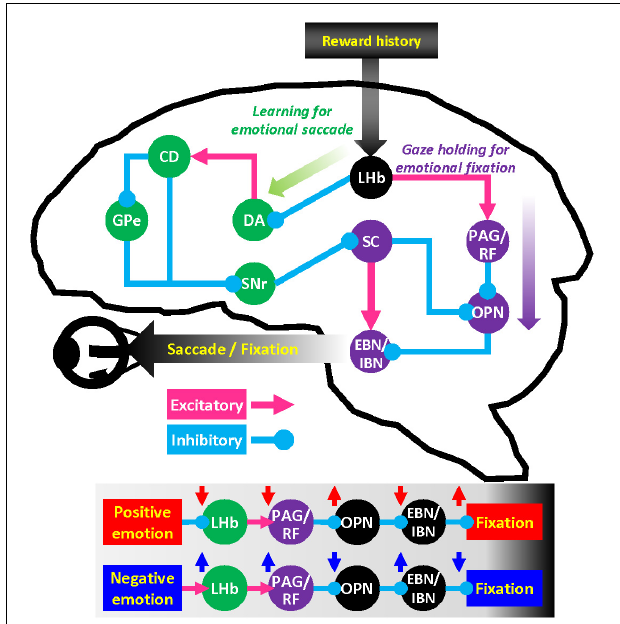
FIGURE 4 | Hypothetical network for the influence of emotion on gaze. LHb neurons regulate dopamine (DA) neurons in substantia nigra pars compacta and ventral tegmental area through rostromedial tegmental nucleus. Dopamine neurons in turn send signals to caudate head (CD) nucleus that projects to superior colliculus (SC) via the external segment of the globus pallidus (GPe) and substantia nigra pars reticulata (SNr). This basal ganglia–SC circuit can modulate learning of goal-directed saccadic eye movements. LHb also has substantial projections to the brainstem structures such as periaqueductal gray (PAG) and reticular formation (RF). These brainstem areas can regulate premotor burst neuron (EBN/IBN) and omnipause neuron (OPN) that control the oculomotor